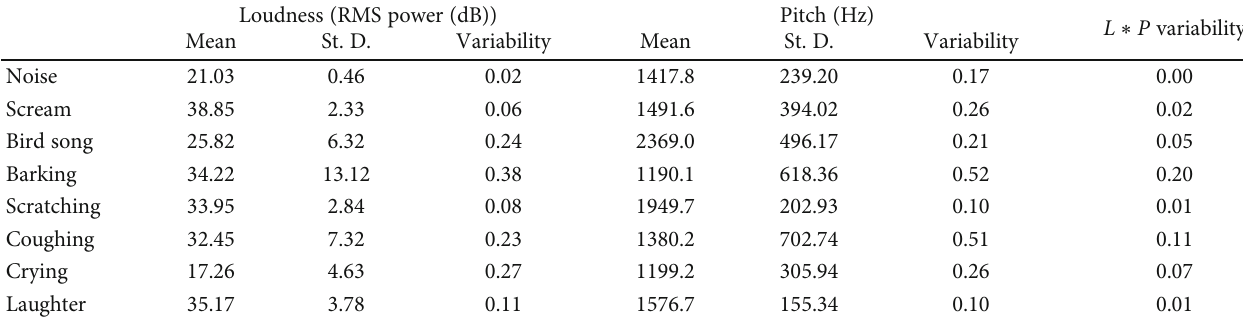
Table 1: Physical parameters of auditory